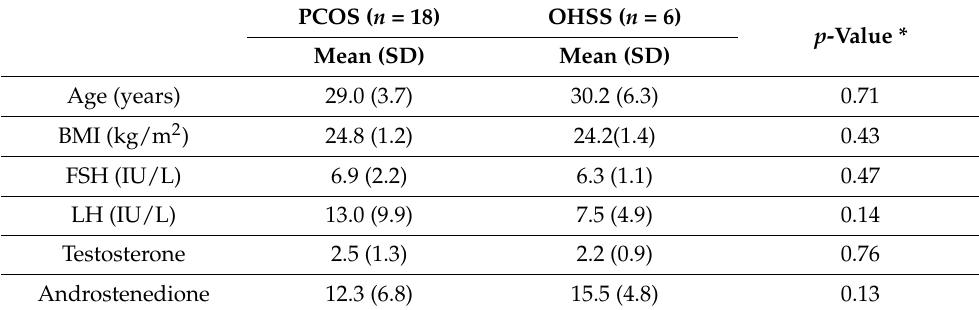
Table 1. Comparison of clinical parameters between OHSS group and PCOS group.